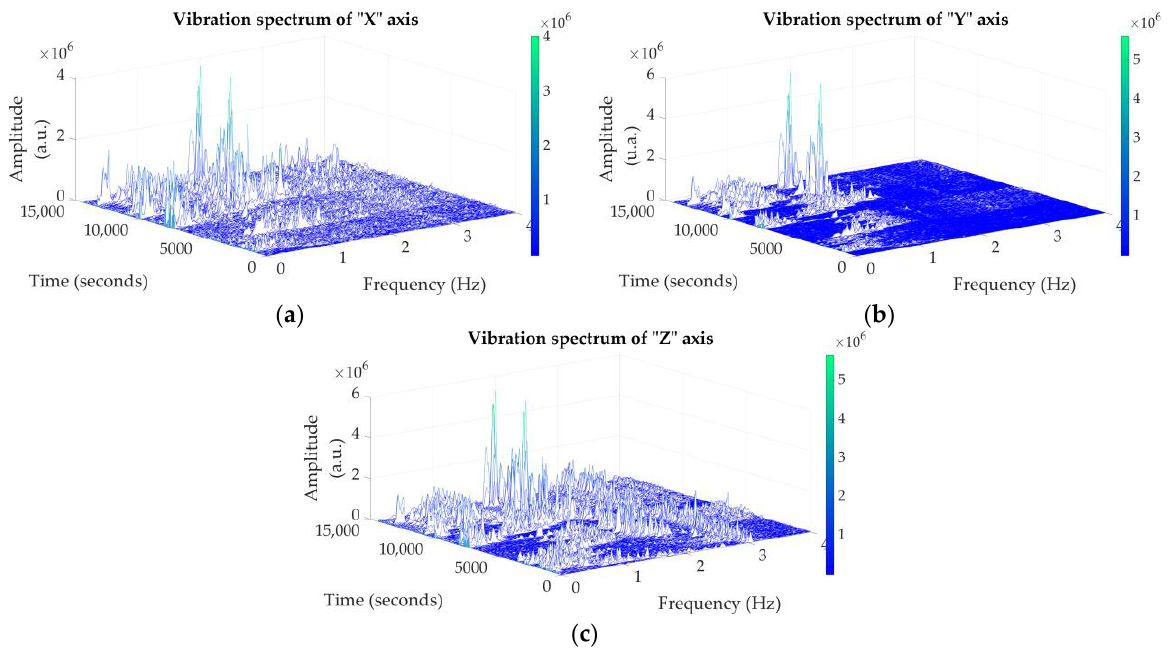
Figure 14. ( a ) vibration spectrum on the “X” axis ( b ) vibration spectrum on the “Y” axis ( c ) vibration spectrum on the “Z” axis; a.u (arbitrary units) .